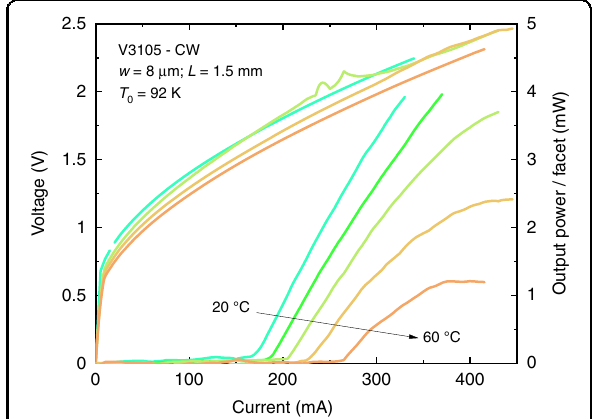
Fig. 6 L – I – V curves in CW at various temperatures for a narrow- ridge GaSb DL grown on a Si substrate with a 0.18° residual miscut angle. The DL was tested in CW from 20 °C to 60 °C,